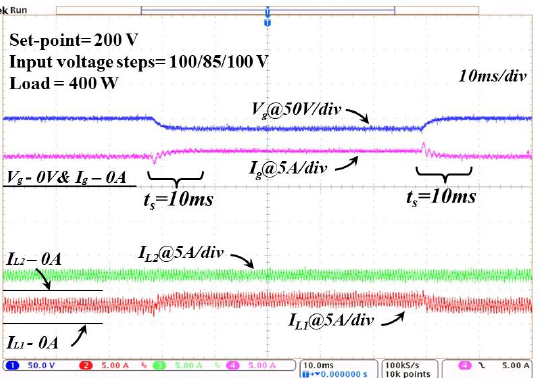
Figure 29. Closed-loop test, the input voltage Vg changes from 100 V to 85 V and then 100 V again, Vo is regulated to 200 V , Po = 400 W .